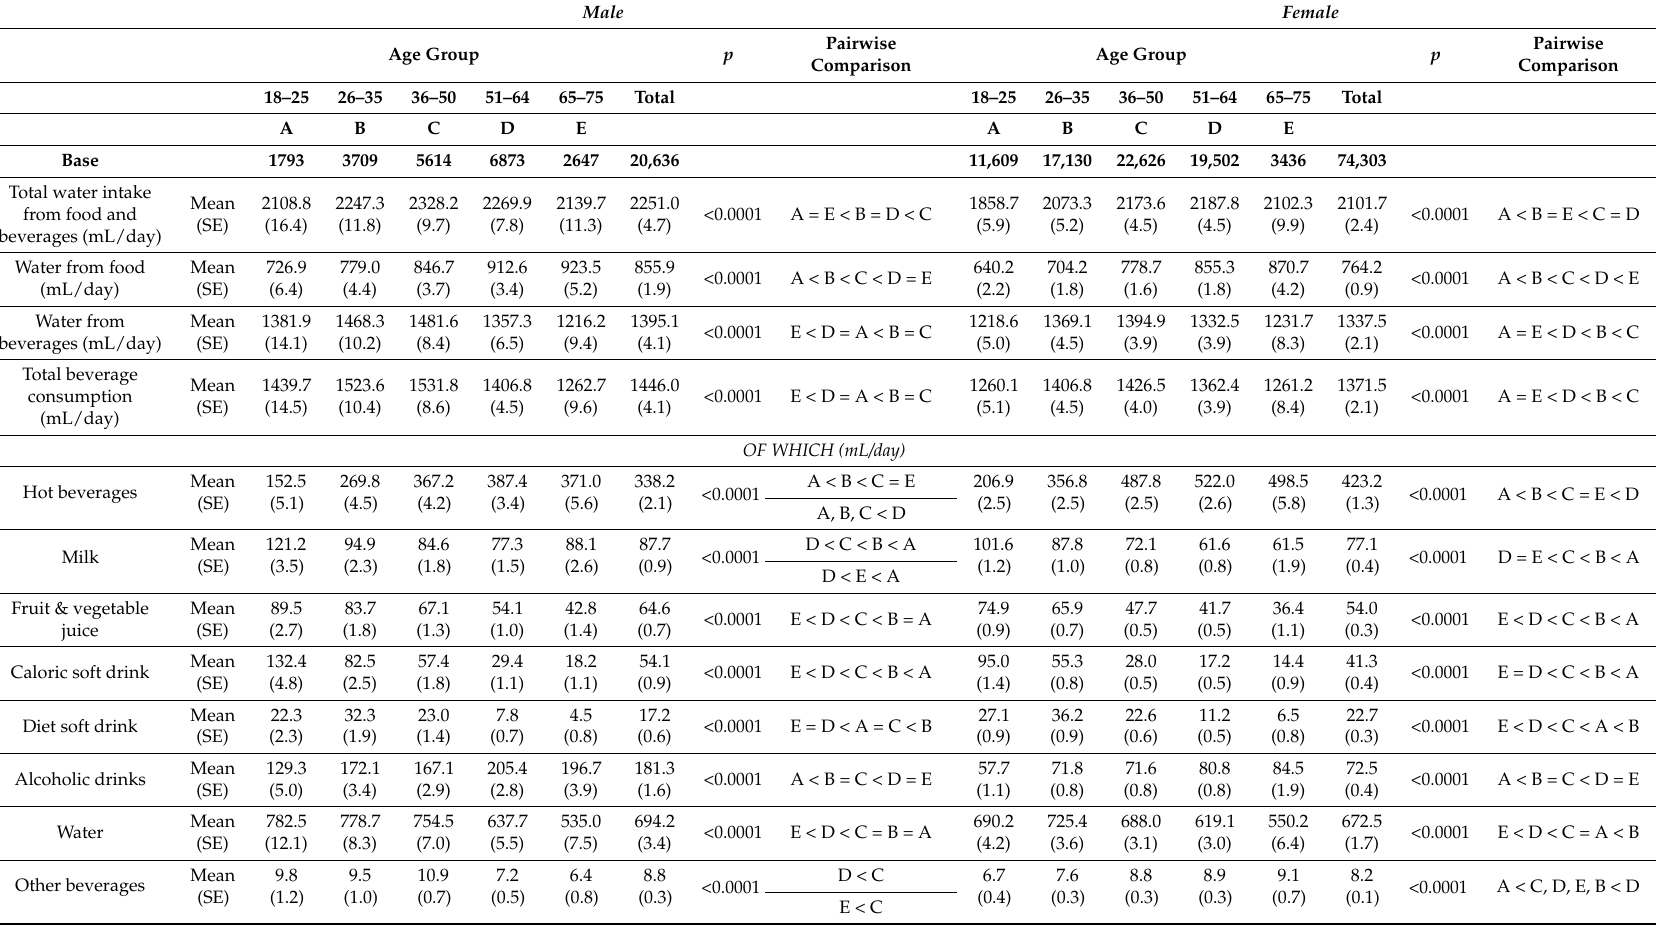
Table 4. Results of ANOVA test for total water intake (g/day) and beverage consumption (mL/day), by gender and by age